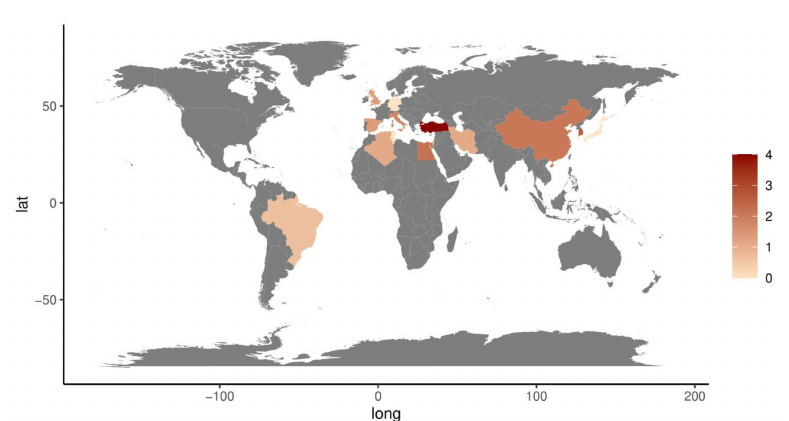
Figure 3. Graphical representation of the global origin of the publication rate of the analyzed studies per country, colored by BD study rate. The graphical representation was computed by log- transforming the number of research papers published by each country. It is possible to recognize the Silk Road pattern. The map was created using the package Ggplot2 [124] of R studio